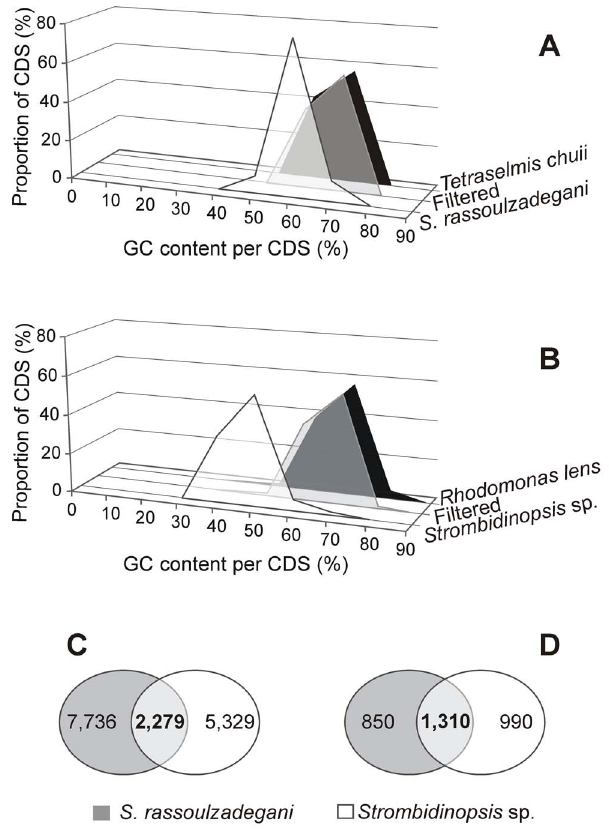
Figure 1. Comparison of Strombidium rassoulzadegani and Strombidinopsis sp. transcriptomes. A-B Frequency distribution of GC content in ciliate transcripts, algal food transcripts, and putative food transcripts filtered from ciliate data. C- Venn diagram of all- against-all BLASTP hits between ciliates. D- Venn diagram of orthologous and paralogous amino acid sequence groups in ciliates.